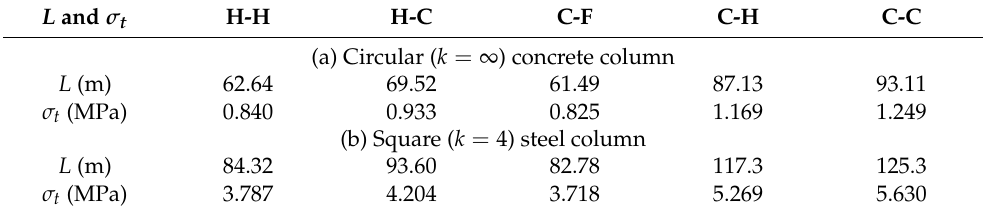
Figure 7. Examples of buckling stress σ for a concrete column with a circular cross-section, n = 0.5, V = 10 m 3 , E = 20 GPa, and γ = 23 kN/m 3 : ( a ) self-weight buckling ( P = 0) and ( b ) external load buckling ( B = 5 MN). Table 5. Tallest buckling length L and buckling stresses σ t of heavy columns * without compressive load.